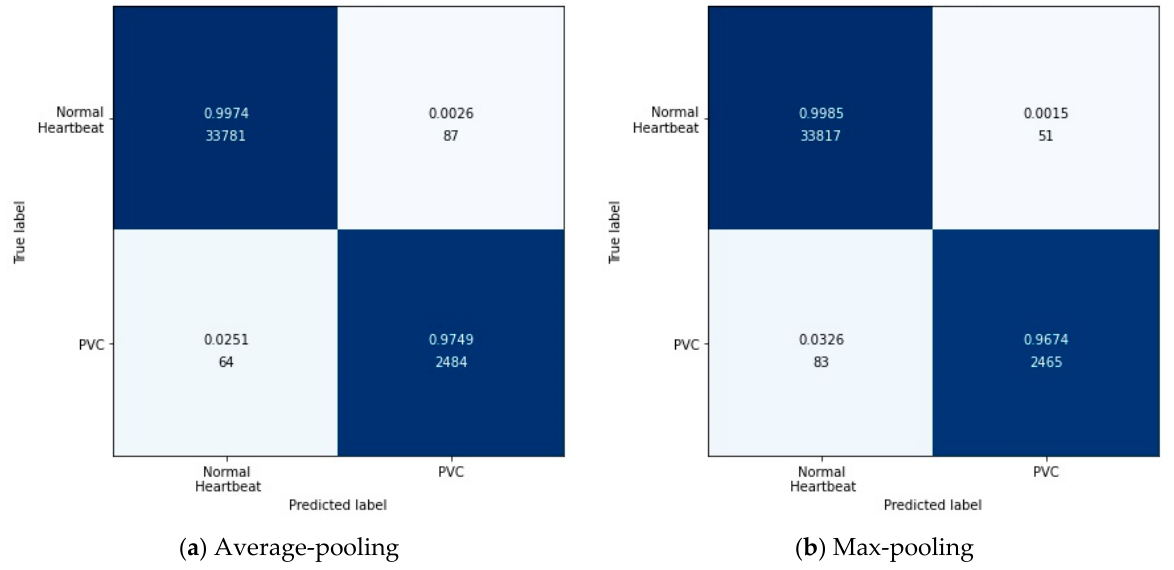
Figure 7. The confusion matrix about testing the pooling layer. Table 10. The detailed results of testing the pooling layer.